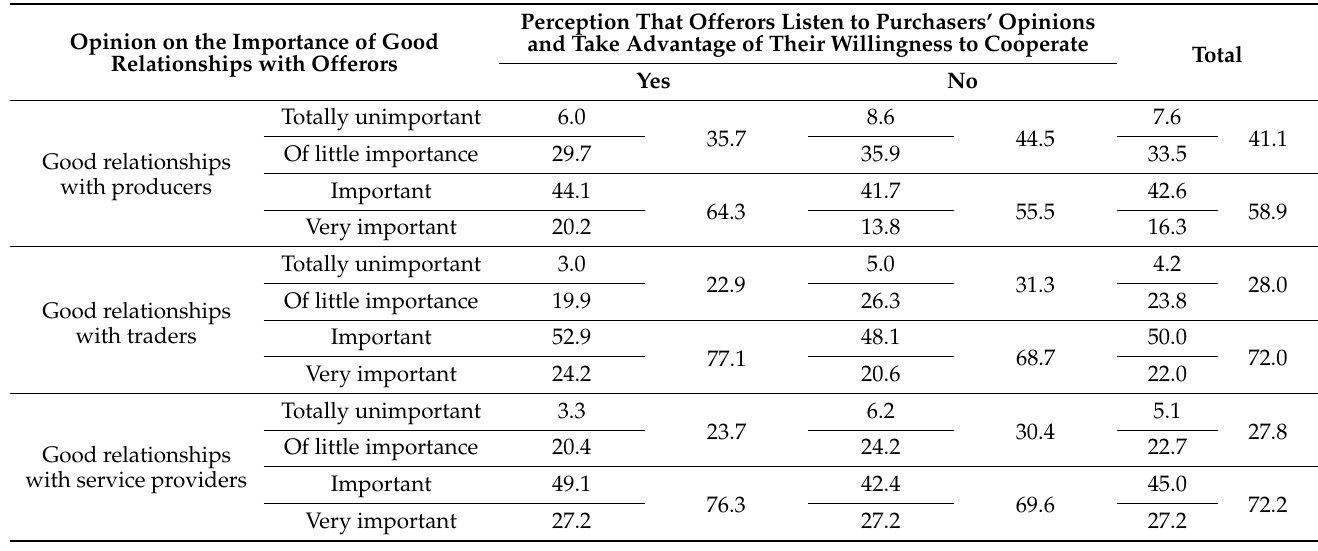
Table 1. Respondents’ opinions about the importance of good relationships with offerors and their perception of offerors as entities that listen to purchasers’ opinions and take advantage of their willingness to cooperate (%). Opinion on the Importance of Good Relationships with Offerors